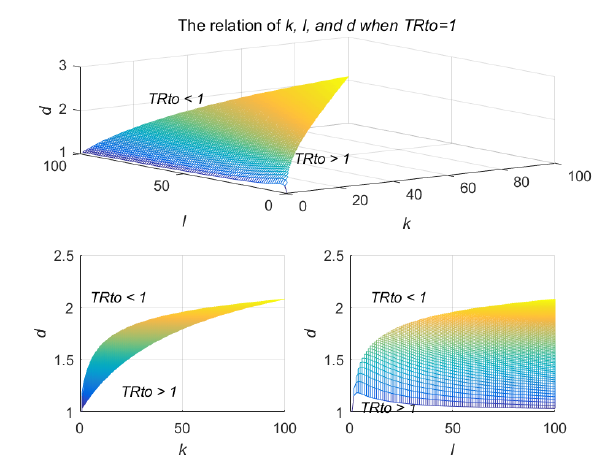
Figure 11. The relation of k , l , and d when TRto =